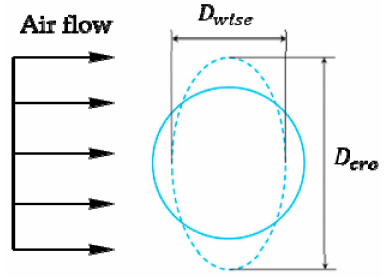
Figure 10. The deformation parameter of